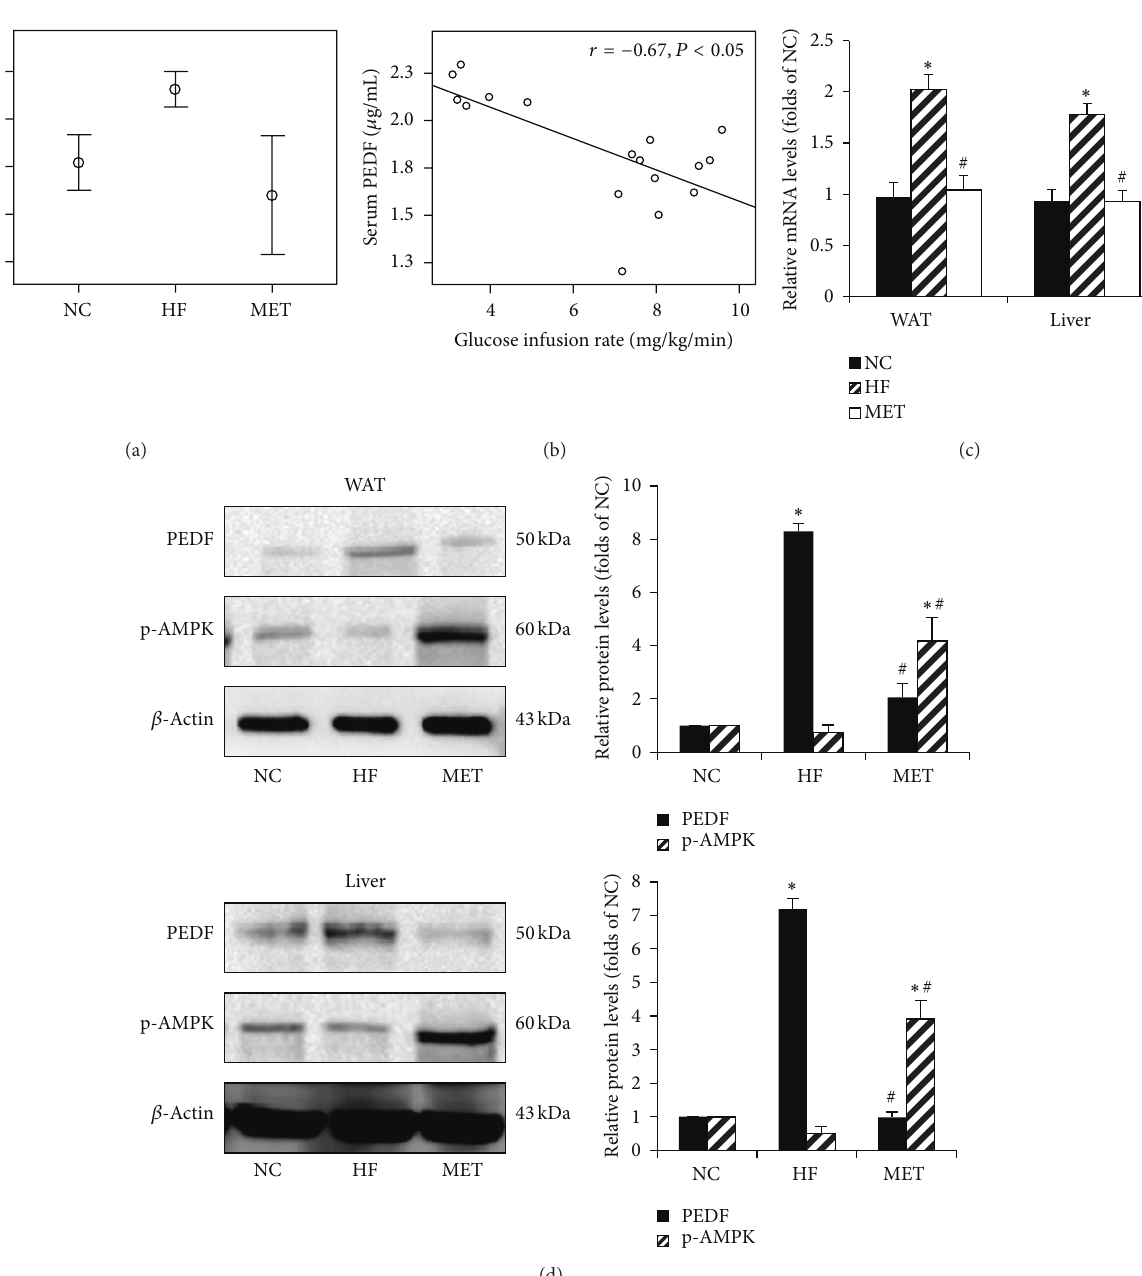
Figure 2: Effects of metformin on the serum PEDF levels and PEDF expression in the adipose tissue and liver of the obese rats. SD rats were fed a normal chow diet (NC group, 𝑛 = 6 ) or a high fat diet ( 𝑛 = 12 ) for 15 weeks; then the high-fat-diet rats were gavaged saline (HF group, 𝑛 = 6 ) or metformin 400 mg/kg/d (MET group, 𝑛 = 6 ) for 4 weeks. At the end of the 19th week, hyperinsulinemic-euglycemic clamp were performed, and the serum, liver, and adipose tissues were collected. (a) Error bar charts showed the serum PEDF concentrations in different groups; (b) Scatter plots showed a negative correlation between serum PEDF levels and insulin sensitivity; (c) RT-PCR assay results of PEDF mRNA levels in WAT and liver; (d) Western blot analysis of PEDF protein expression and phosphorylation of AMPK. The histogram represents mean ± SD of the densitomeric scans for protein bands from three experiments, normalized by comparison with 𝛽 -actin and expressed as a percentage of control. ∗ 𝑃 < 0.05 , compared with NC group. # 𝑃 < 0.05 , compared with HF